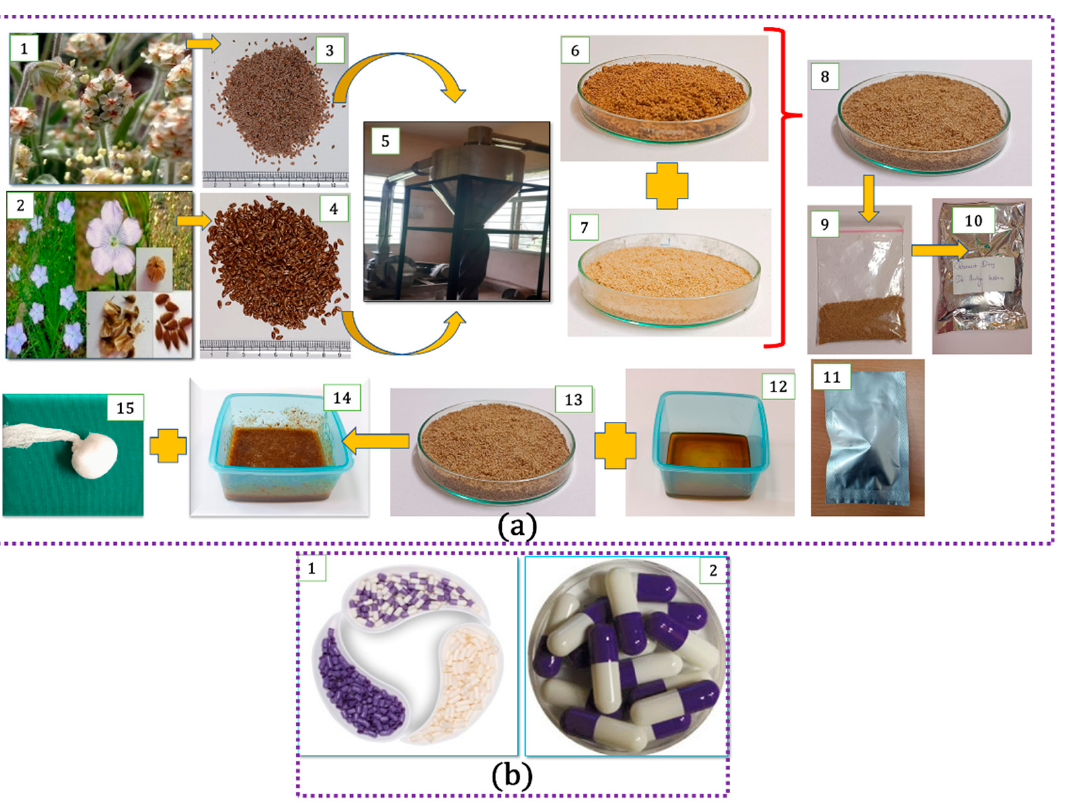
Figure 2. Depiction of pessary preparation: ( a ) (1) Plantago ovata plant; (2) Linum usitatissimum L. plant, seeds; (3) Plantago ovata plant, seeds; (4) Linum usitatissimum L plant, seeds; (5) powder-making machine; (6) powder of Linseeds; (7) powder of P. ovata ; (8) mixed powder; (9) dispensing single dose in sachet; (10) sachets packed in the aluminium pouch; (11) dispensing of tampon; (12) honey; (13) mixed powder; (14) powder mixed with honey; (15) impregnation on tampon unfilled; and ( b ) (1) Unfilled and (2) filled placebo capsules.